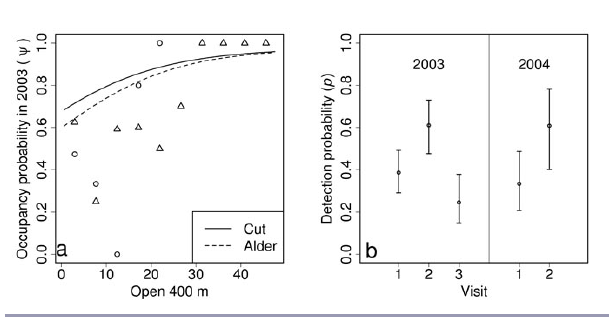
Fig. 2 . Occupancy of Wilson’s Warbler ( Cardellina pusilla ) in clear-cuts and alder ( Alnus spp.) patches of different sizes in 2003. Model-averaged estimates based on multiseason occupancy models for alder and clear-cut combined. (a) Influence of habitat type (clear-cut or alder) and area within a radius of 400 m on occupancy probability of Wilson’s Warbler during 2003 (model-averaged y ). Raw proportions of detections are provided for comparison: triangles denote clearcut sites, circles denote alder sites. (b) Changes in detection probability between point-count